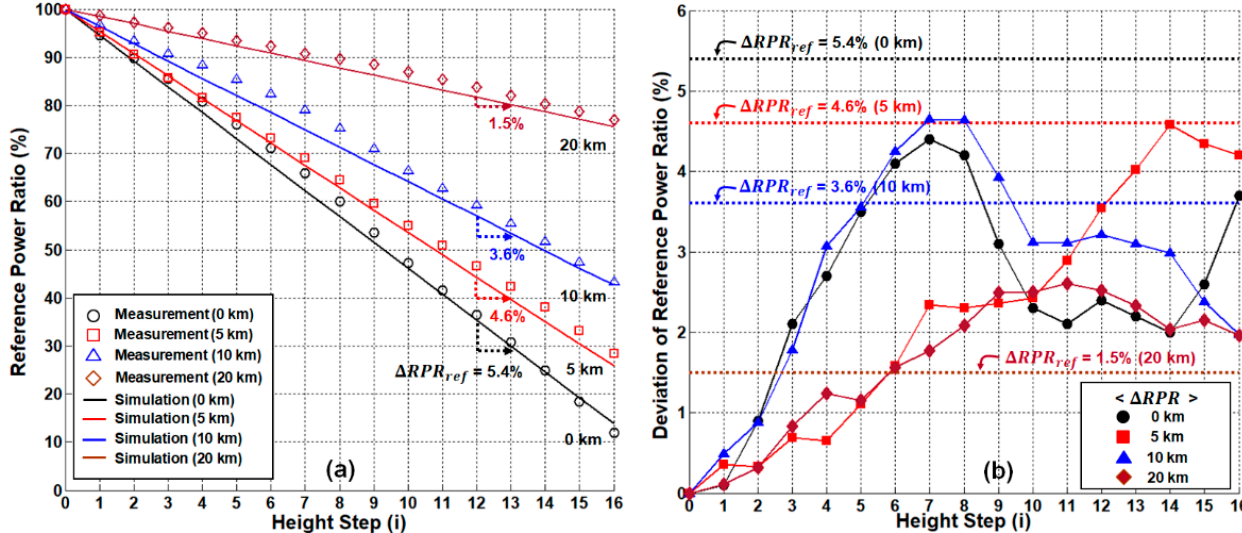
Figure 9. System performance of single-path network configuration. ( a ) Measured/simulated reference-to-power ratios according to the sensing distance. ( b ) Allowable deviation ranges of the reference-to-power ratios for remote sensing.